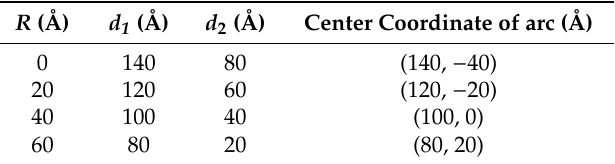
Table 2. Simulation parameters of the grinding